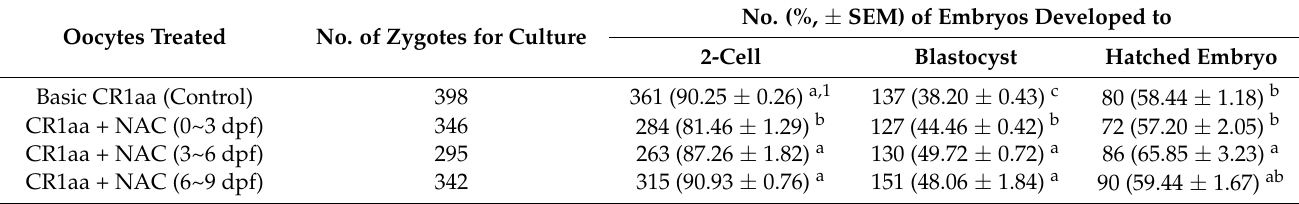
Table 3. Time-dependent effects of NAC supplementation during in vitro culture on bovine embryo development. Oocytes Treated